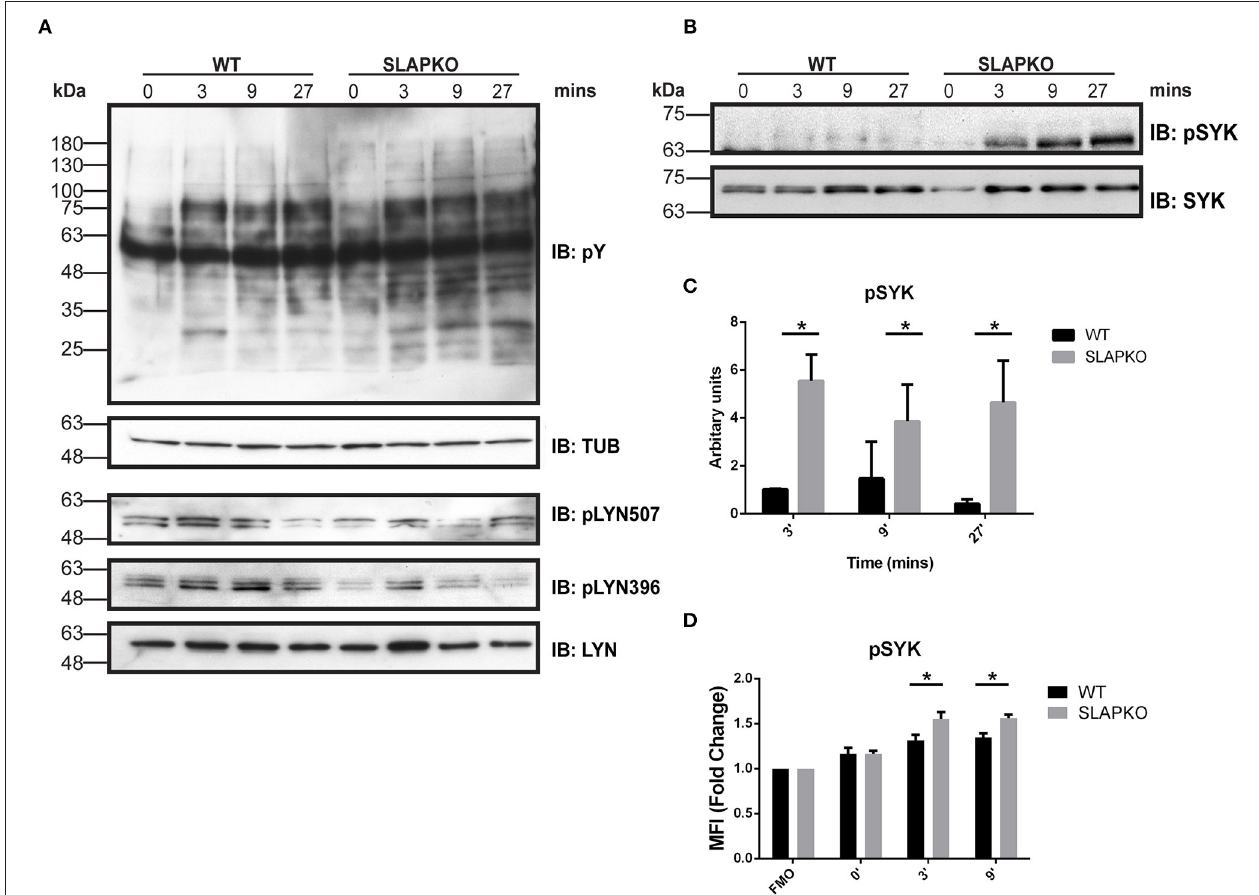
FIGURE 5 | Enhanced Syk signaling in SLAP KO BMMCs. WT and SLAP KO BMMCs were starved and sensitized with Anti-DNP IgE for 18h and then stimulated with DNP-HSA (50ng/ml) for indicated time-points. (A) Lysates were prepared and subjected to immunoblot (IB) with anti-phosphotyrosine (pY), anti-tubulin (TUB), anti-pY396 Lyn, anti-pY507 Lyn, and anti-Lyn. (B) p-Syk Ab, and anti-Syk Abs. Representative immunoblots are shown from three separate experiments ( n = 3). Positions of relative mass markers in kilodaltons (kDa) are shown on the left. (C) Bar graph represents the quantitation of relative pSyk at indicated time points by densitometry quantification. Data (mean ± SD) in bar graph represents the pooled data from three independent experiments ( n = 3) and compared with Student’s t -test; * P < 0.05 to calculate statistical significance. (D) WT and SLAP KO BMMCs were starved and sensitized with anti-DNP IgE and stimulated with DNP-HSA for indicated time-points, stained with pSyk Ab and median fluorescence intensity was quantified by phosphoflow cytometry. Bar graphs showing the average of normalized MFI (fold change) of pSYK at indicated time-points compared to respective fluorescence minus one (FMO) control from each genotype. Data (mean ± SD) in bar graph represents the pooled data from three independent experiments ( n = 3; Student’s t -test; * P <